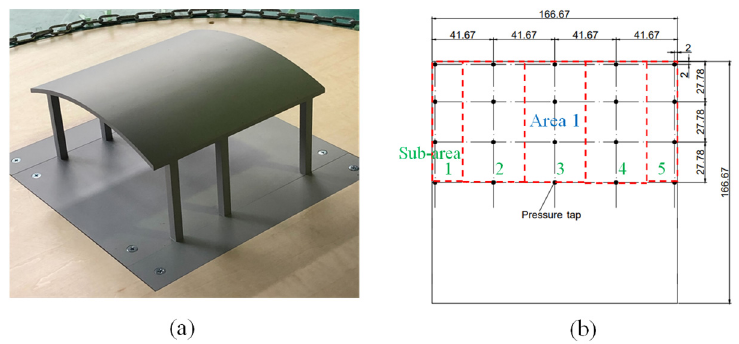
Figure 3. Wind tunnel model: ( a ) Picture; ( b ) pressure tap arrangement.